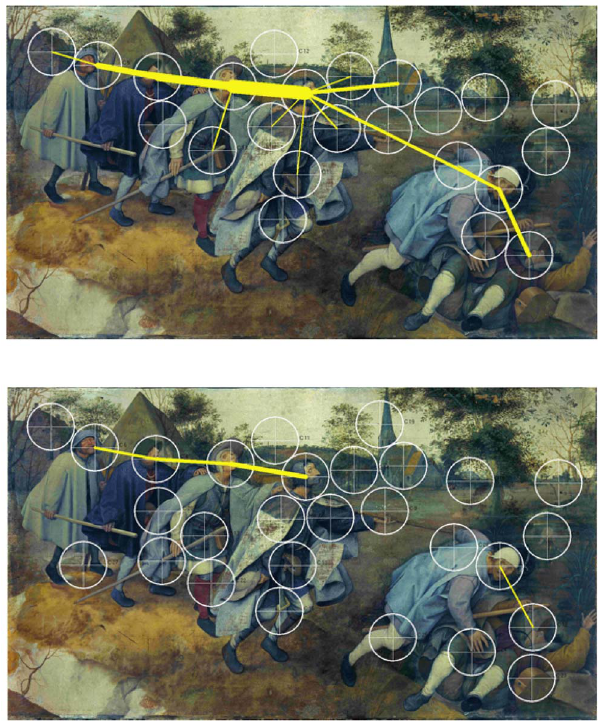
Fig. 7. Speaking effects on frequently repeated transitions between fixation clusters – Bruegel. Upper part: Frequently repeated transitions between fixation clusters of the experimental group during minute 11 to 15. Cluster size: 60 mm. Lower part: Frequently repeated transitions between fixation clusters of the control group during minute 11 to 15. Cluster size: 60